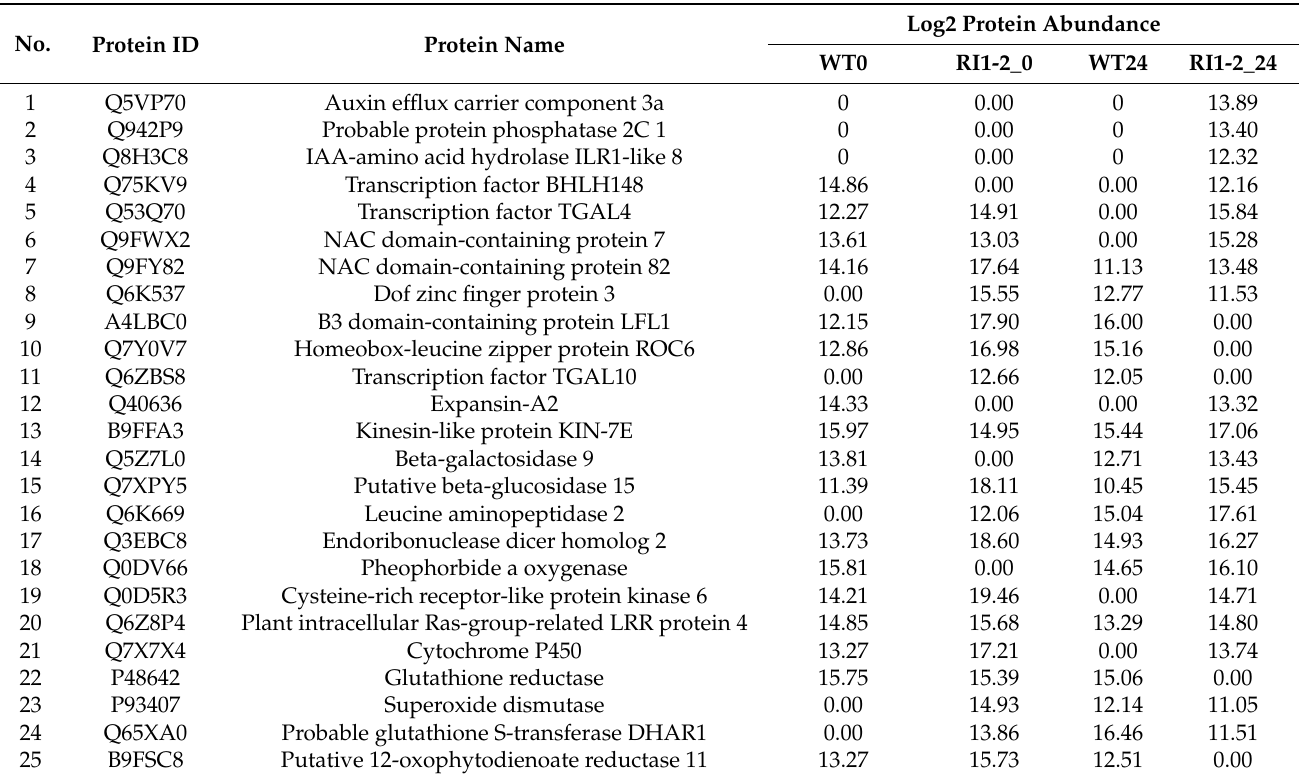
Table 2. Differentially expressed proteins in wild-type (WT) and OsVTC1-1 RI1-2 line at 0 and 24 h post inoculation with 10100